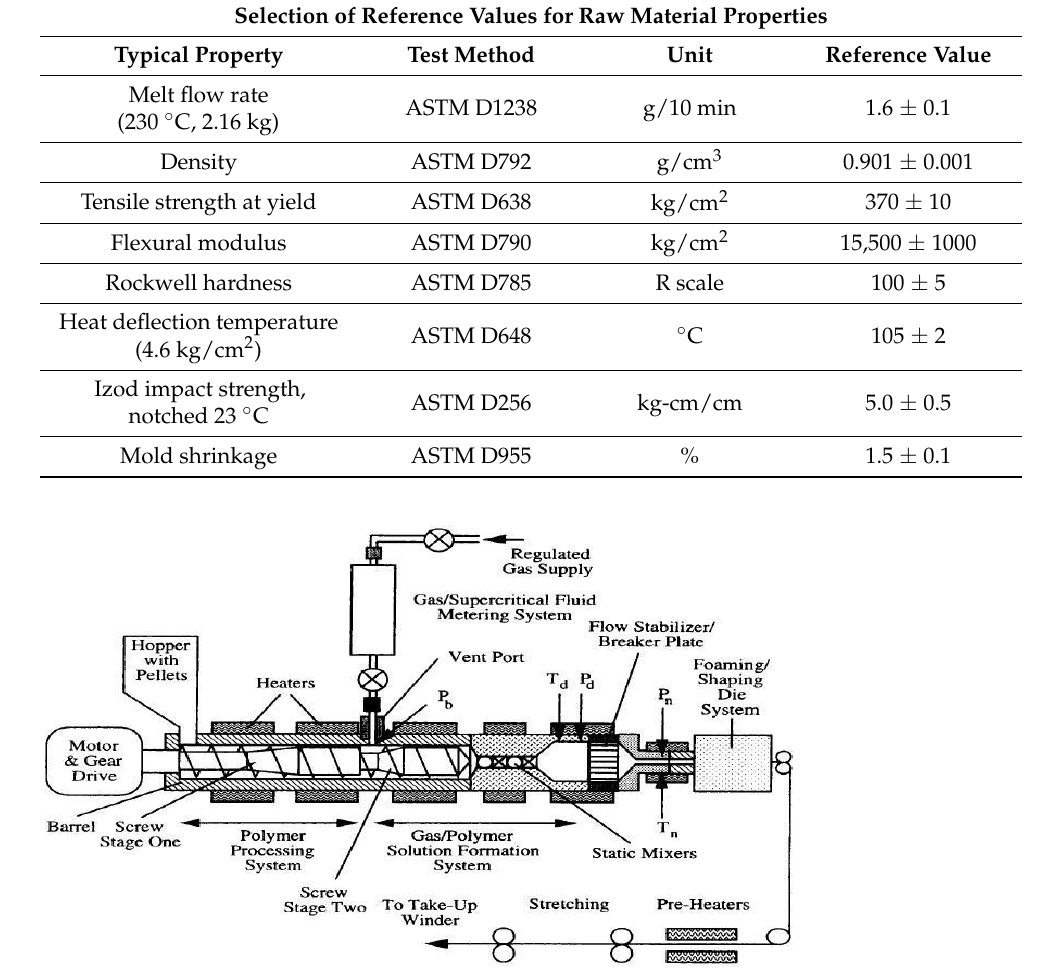
Table 1. Properties of raw materials for producing polypropylene coffee cup lids. Selection of Reference Values for Raw Material Properties Figure 1. Polypropylene coffee lid with molds.